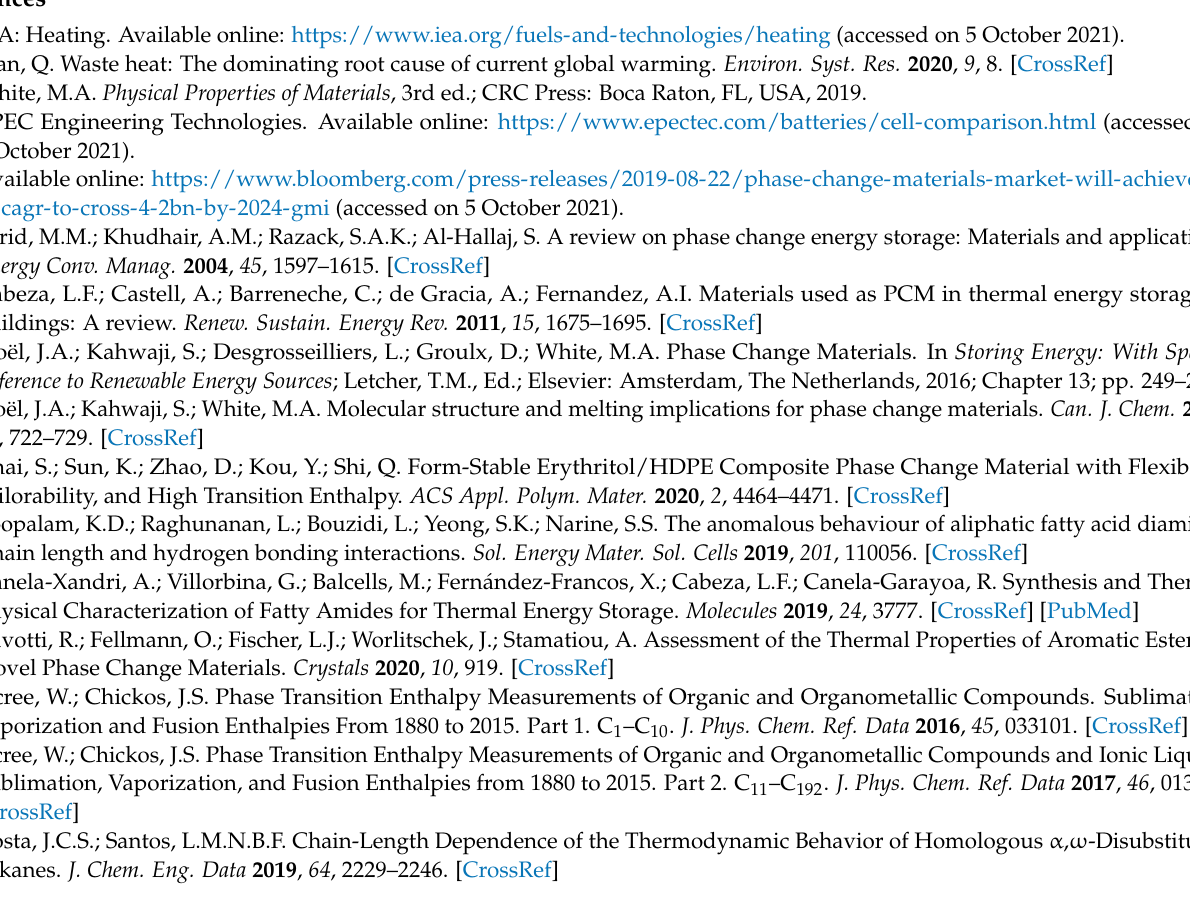
Supplementary Materials: The following are available online. Table S1: Melting points of alkanes with 10 to 55 carbons (data for Figures 1 and 2); Table S2: Thermal properties of alkanes with odd numbers of carbons from 11 to 35 (data for Figures 2 and 5); Table S3: Thermal properties of alkanes with even numbers of carbons from 10 to 46 (data for Figures 2 and 5); Table S4: Melting points and enthalpies of fusion of fatty alcohols with 13 to 26 carbons (data for Figures 1 and 6); Table S5: Melting points and total enthalpies of transition of fatty alcohols with 12 to 26 carbons (data for Figure 6); Table S6: Melting points and enthalpies of fusion of fatty acids with 11 to 26 carbons (data for Figures 1 and 7); Table S7: Melting points and enthalpies of fusion for esters with 10 to 38 carbons (data used for Figures 1, 3 and 8); Table S8: Melting points and enthalpies of fusion of diamides with 8 to 14 carbons (data for Figures 1 and 7); Table S9: Melting points and enthalpies of fusion of diamines with 8 to 12 carbons (data for Figures 1 and 9); Table S10: Melting points and enthalpies of fusion for dinitriles with 10 to 14 carbons (data for Figures 1 and 9); Table S11: Melting points and enthalpies of fusion for diols with 10 to 20 carbons (data for Figures 1 and 9); Table S12: Melting points and enthalpies of fusion of dioic acids with 10 to 18 carbons (data for Figures 1 and 9). All Tables include their literature